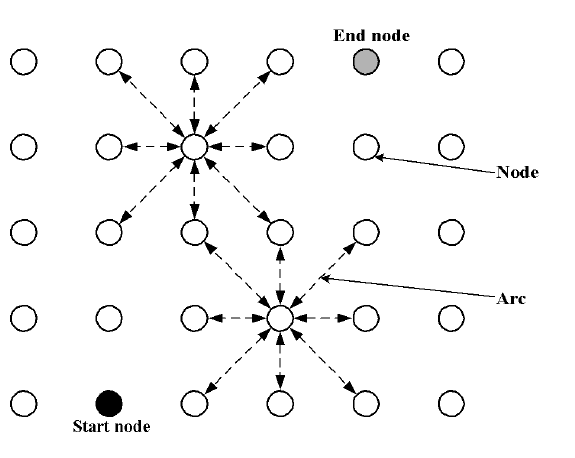
Figure 1: The routing structure and some nomenclature.